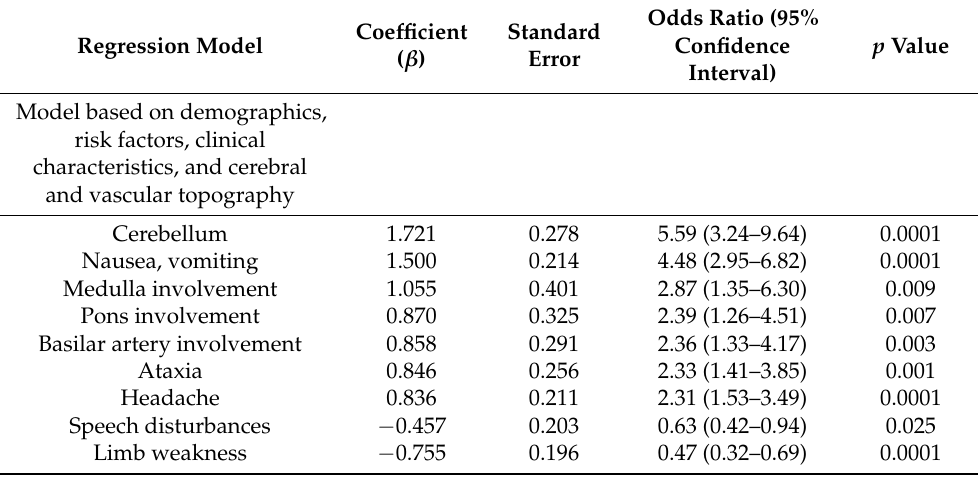
Table 3. Results of multivariate analysis: variables independently associated with vertigo in acute stroke